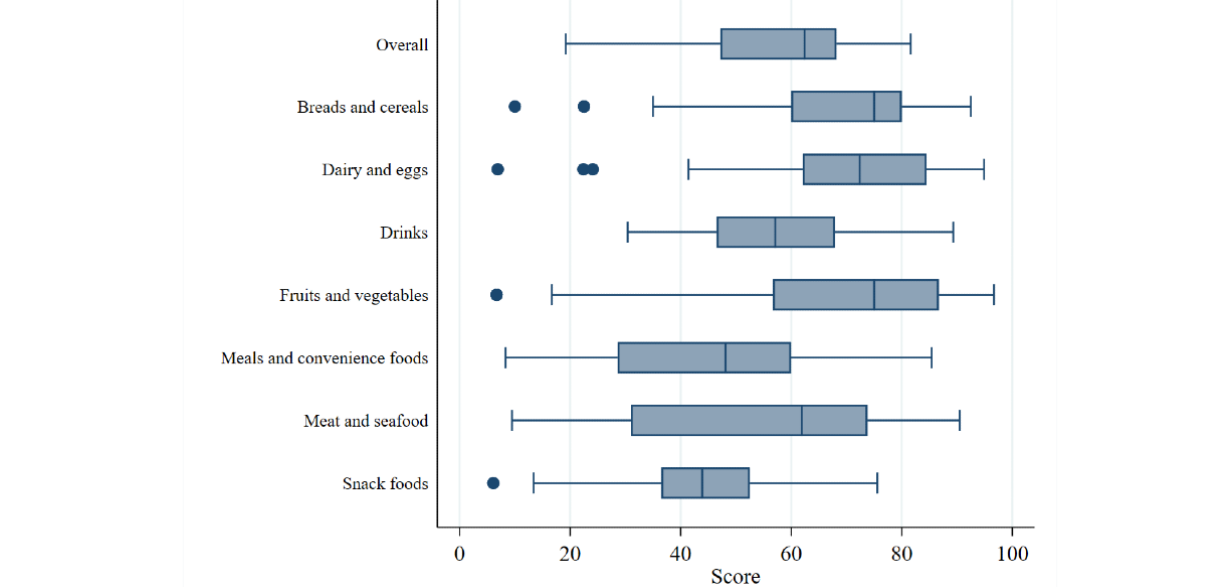
Figure 1. Distribution of overall and category scores for the combined sample of 54